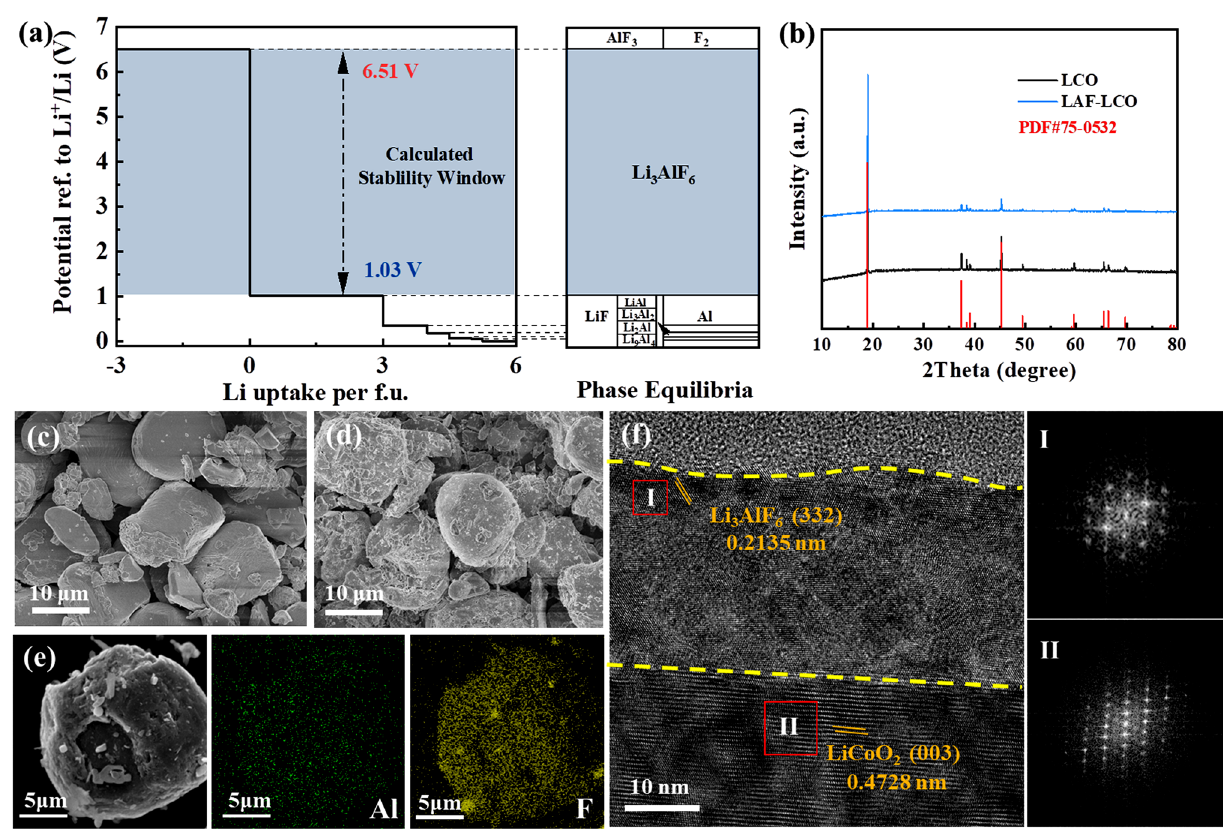
Fig. 1 a Thermodynamic equilibrium voltage profile and phase equilibria of Li 3 AlF 6 . b XRD patterns of LCO and LAF@LCO. SEM image of c LCO particles and d LAF@LCO particles. e EDS elemental maps of Al and F on a LAF@LCO particle. f HRTEM images of LAF@LCO. ( I and II ) FFT patterns of marked region I and II in f ,